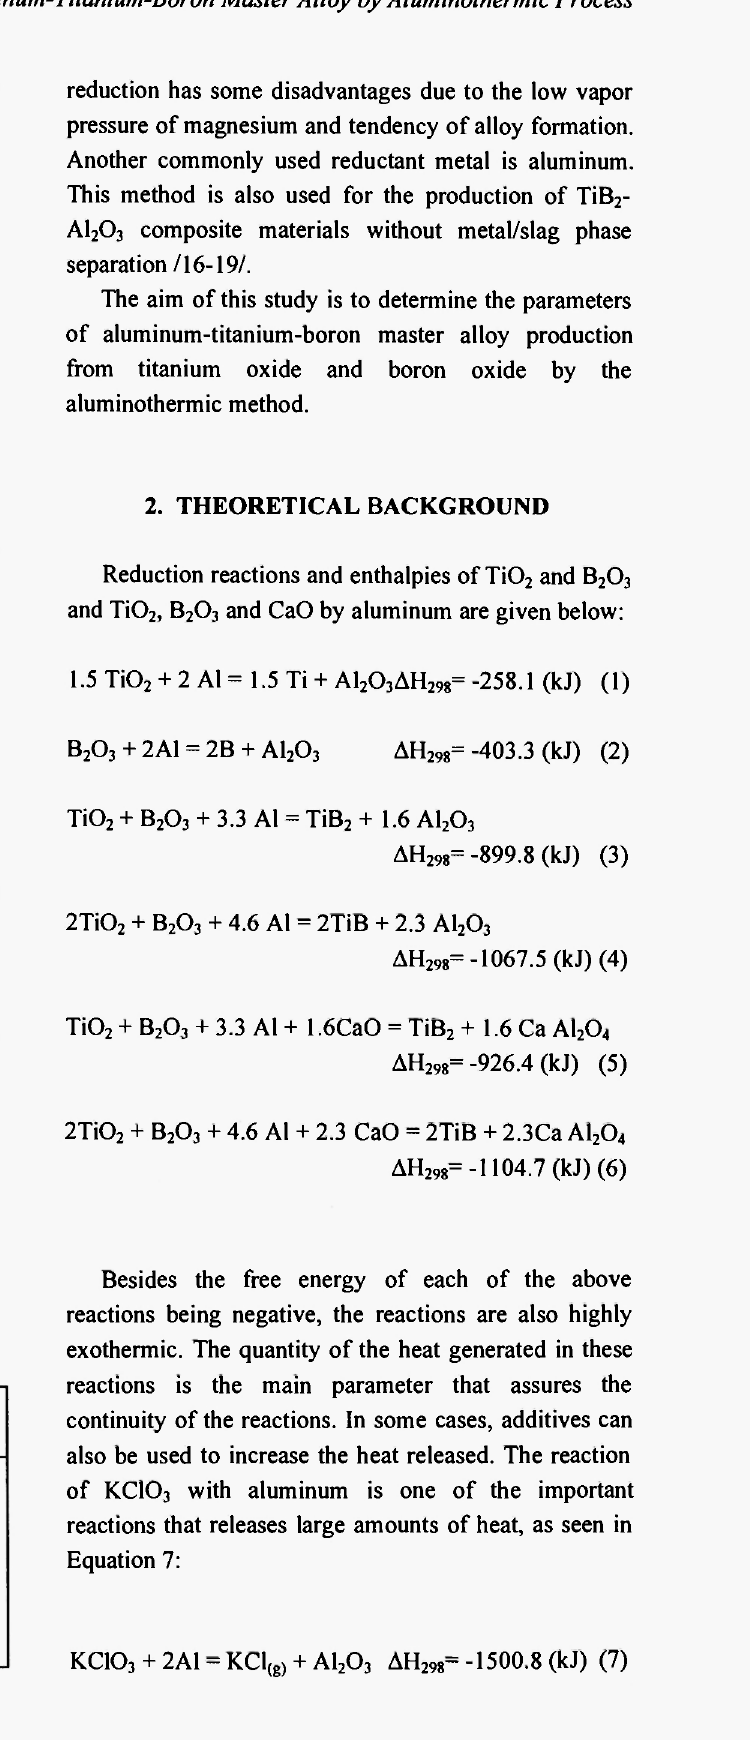
Physical and thermodynamic properties of metallothermic reaction reactants